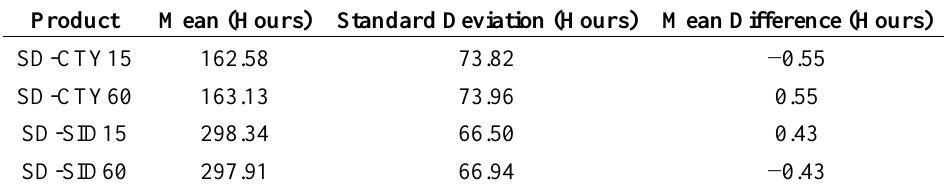
Table 3. Mean, standard deviation, and mean difference relative to the other temporal resolution, for the SD-CTY and SD-SID products with 15-minute and 1-hourly bases. The results are calculated for monthly totals from March 2009 for SD-CTY, and August 2007 for SD-SID over the whole